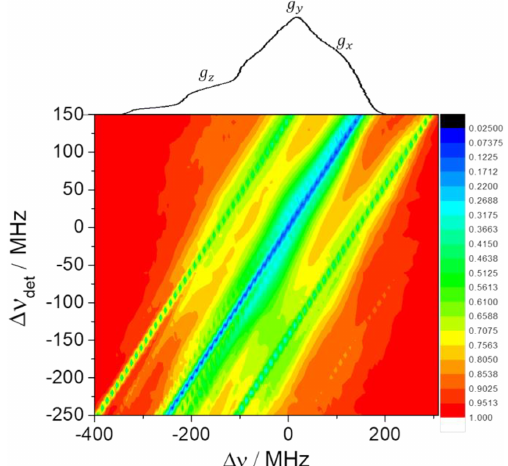
Figure 5. Experimental 2D ELDOR spectra of 10mM TEMPOL solution at 20K.